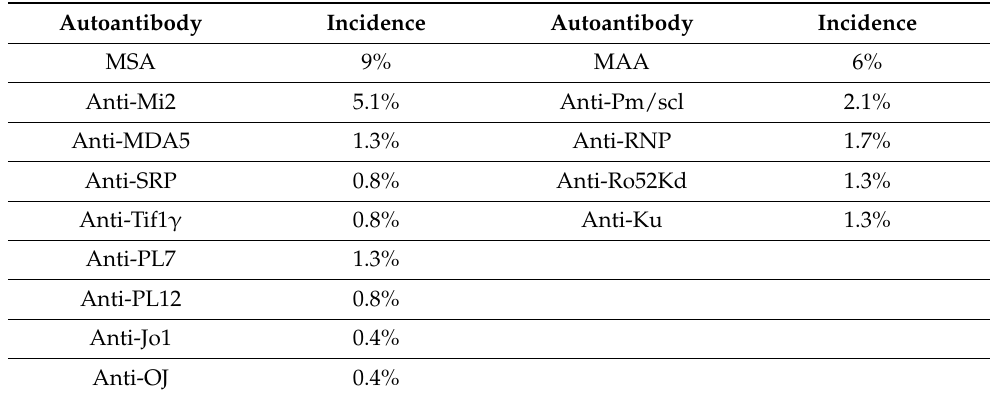
Table 2. Incidence of Myositis-Specific and Myositis-Associated Autoantibodies in the Fibromyalgia cohort. Autoantibody Incidence